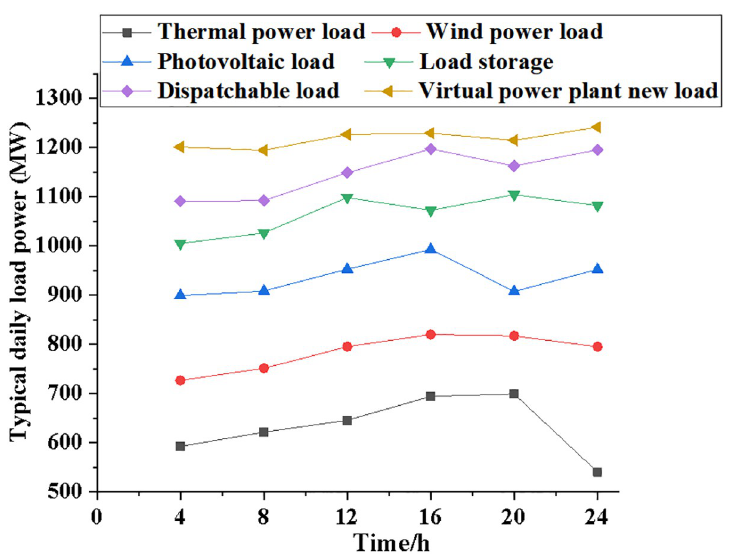
Fig 7. Typical daily load power comparison of different electric load types.